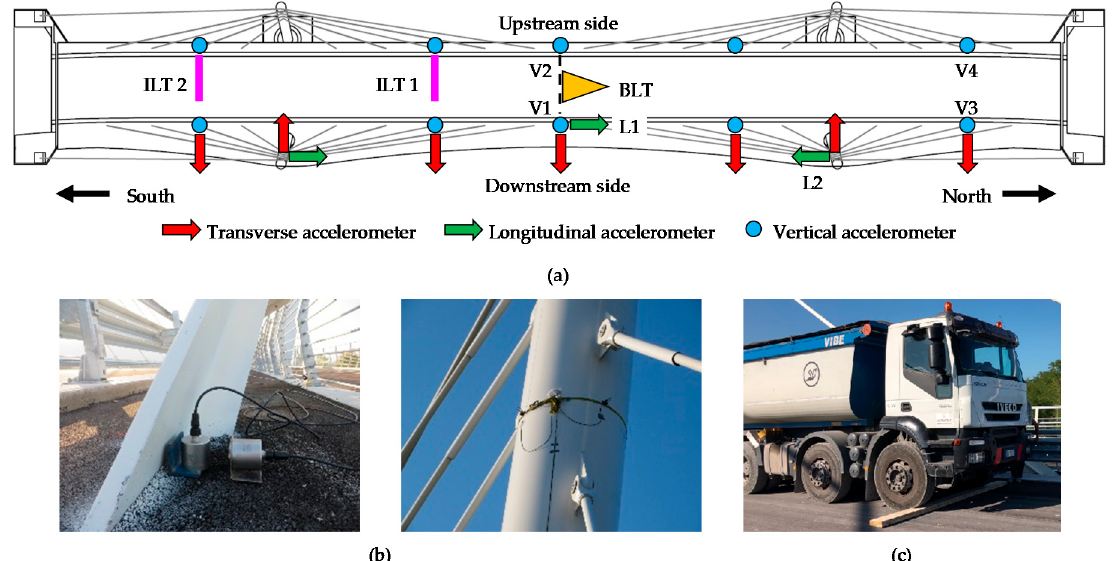
Figure 5. Dynamic proof test instrumentation and sensor arrays: ( a ) accelerometers layout for AVTs, ILTs, and BLTs, ( b ) pictures that are relevant to the adopted instrumentation, and ( c ) truck passing over a bump during